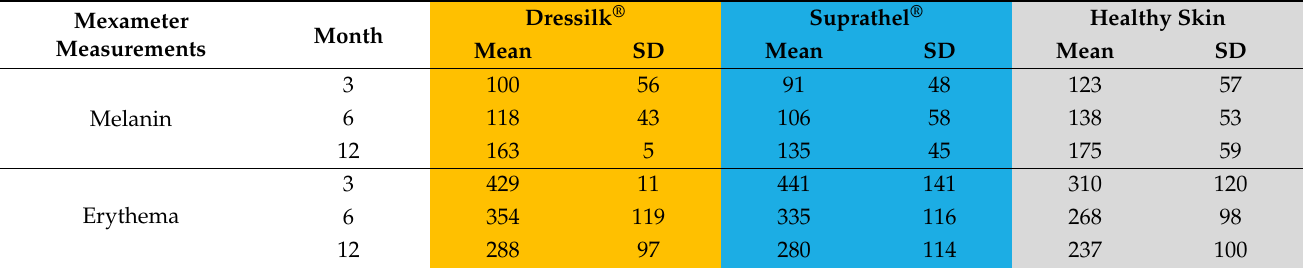
Figure 4. Level of melanin in arbitrary Mexameter ® units after 12 months of areas treated initially with Suprathel (blue), Dressilk (orange) and the uninjured control area (green). Thus, the wound areas treated with Dressilk ® showed no significant difference in pigmentation in comparison with normal skin, whereas those treated with Suprathel ® showed a significant difference ( p = 0.004). In assessments of erythema, both dressings showed significantly higher values than those for normal skin after three, six, and twelve months, whereas the inter-therapeutic difference was not significant (Table 3). Table 3. Level of melanin/erythema in arbitrary Mexameter ® units after 3, 6 and 12 months of areas treated initially with Suprathel, Dressilk and the uninjured control area.